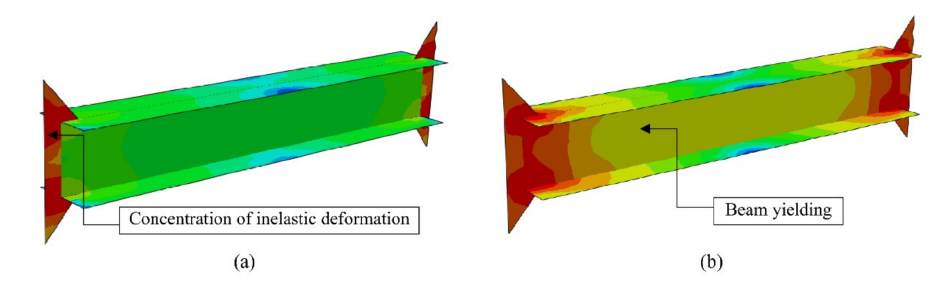
Figure 14. Effect of the ratio of plastic bending moment on the failure mechanism of the plate as a fuse and the beam: ( a ) concentration of plastic hinge in the connection plate and ( b ) beam